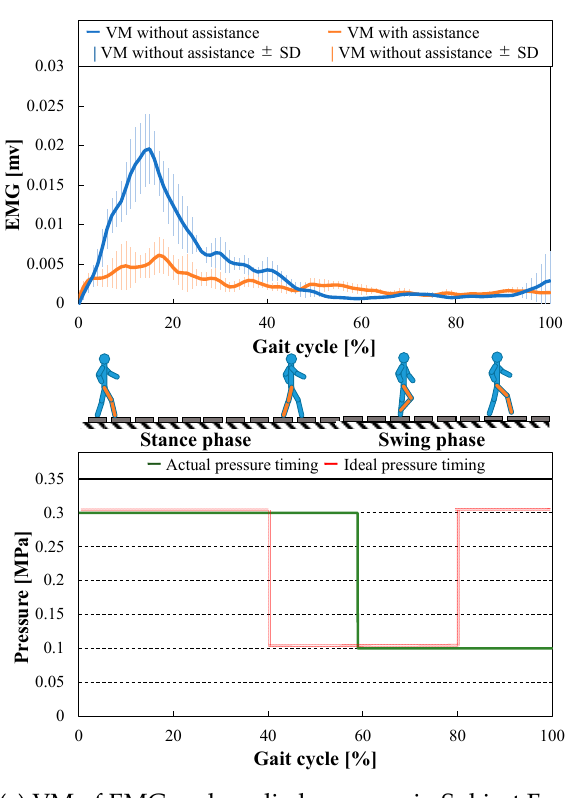
Figure 15. Comparison of EMG with and without assistance and applied pressure to the prototype in one gait cycle (1.5 km/h).